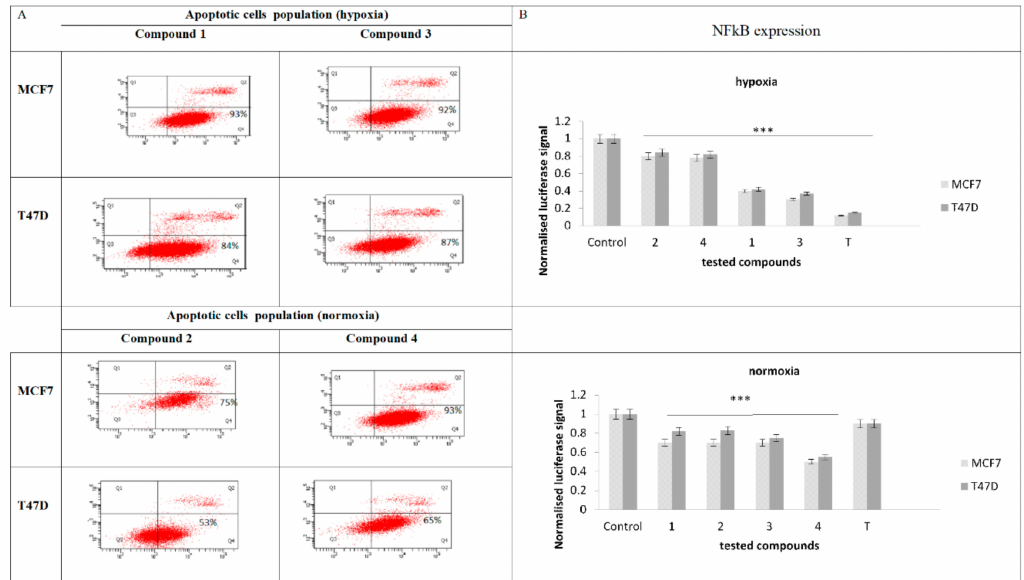
Figure 5. ( A ) Apoptotic cell population analysis for IC 50 in T47D and MCF7 cell lines after 24